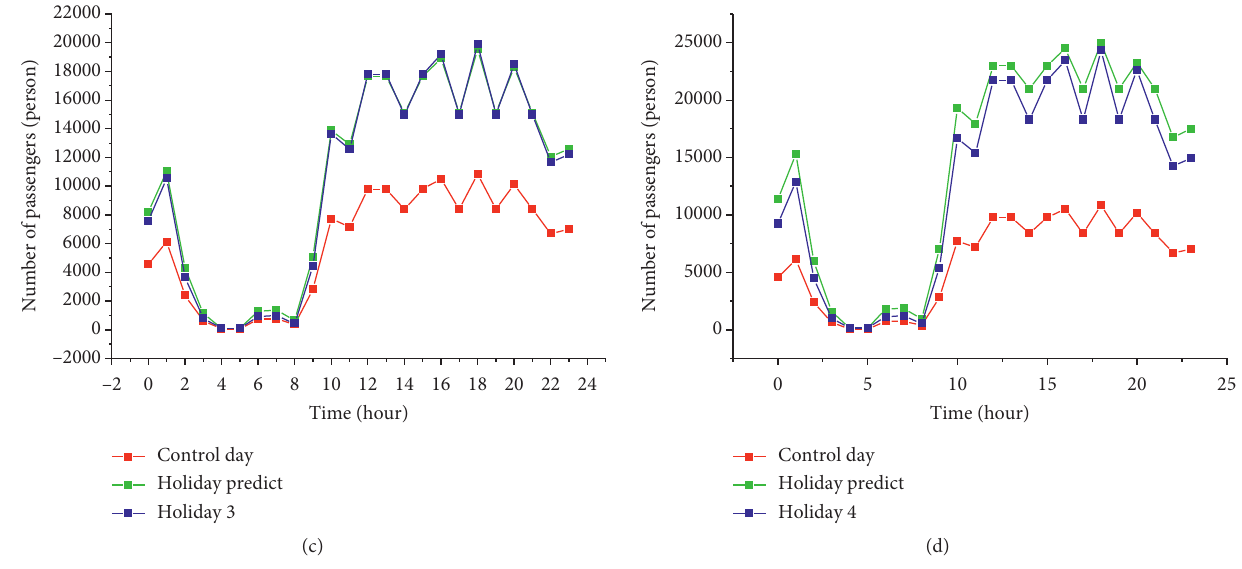
Figure 10: Comparison between data and prediction on weather condition from level 1 to level 4.